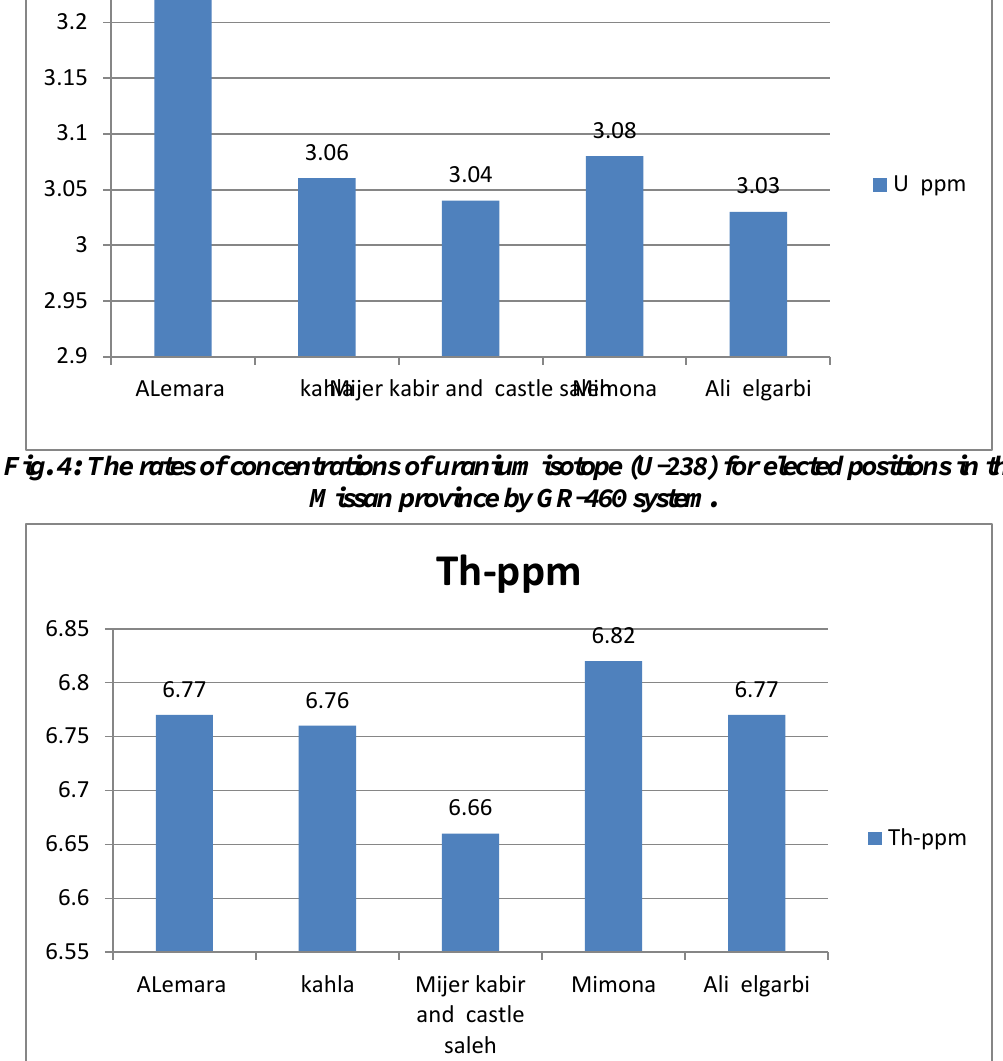
Fig. 5: The rates of concentrations of thorium isotope (Th-232) for elected positions in the province of Missan by GR-460 system